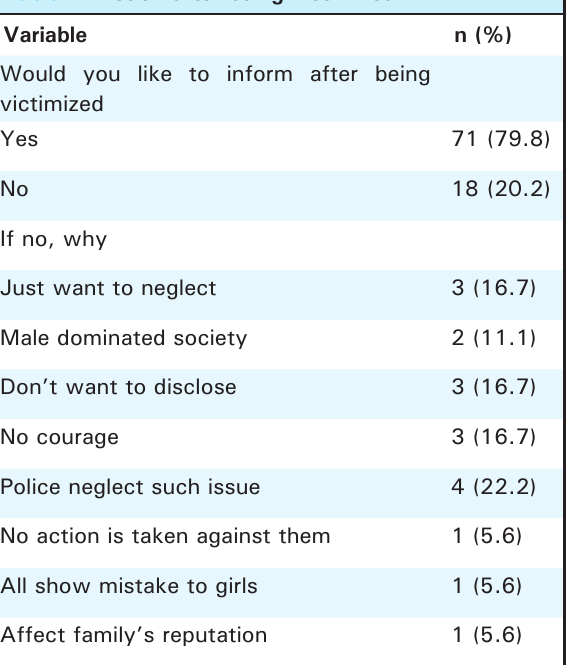
Table 2. Action after being victimized.